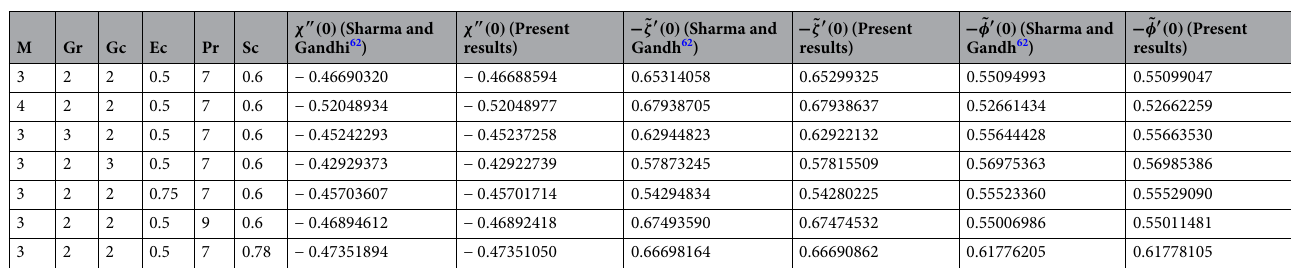
Figure 3. Comparative analysis of ( a ) velocity profile ˜ χ ′ (η) for M = 3, ( b ) temperature profile ˜ ζ(η) for Pr = 7.